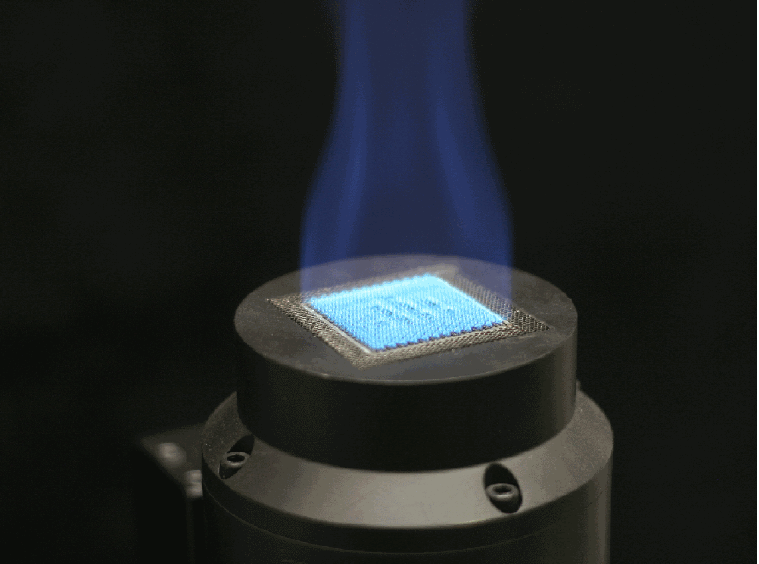
Figure 4. Standard flame burner (Figure previously published in